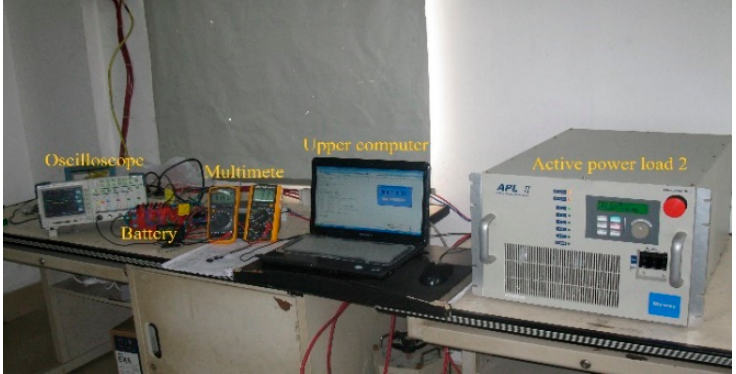
Figure 4. Battery test platform.